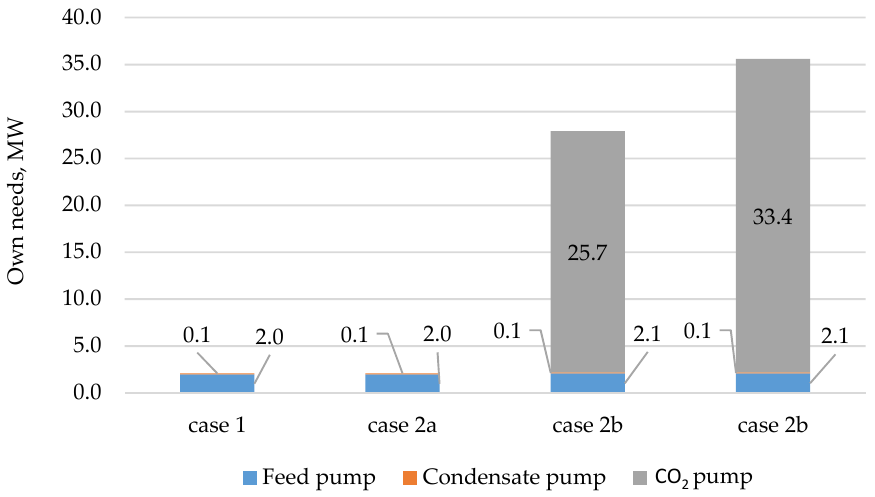
Figure 6. Own needs structure for the different TPPs with BPSTs producing electricity (without heat load) at the ambient temperature of 20 °C.